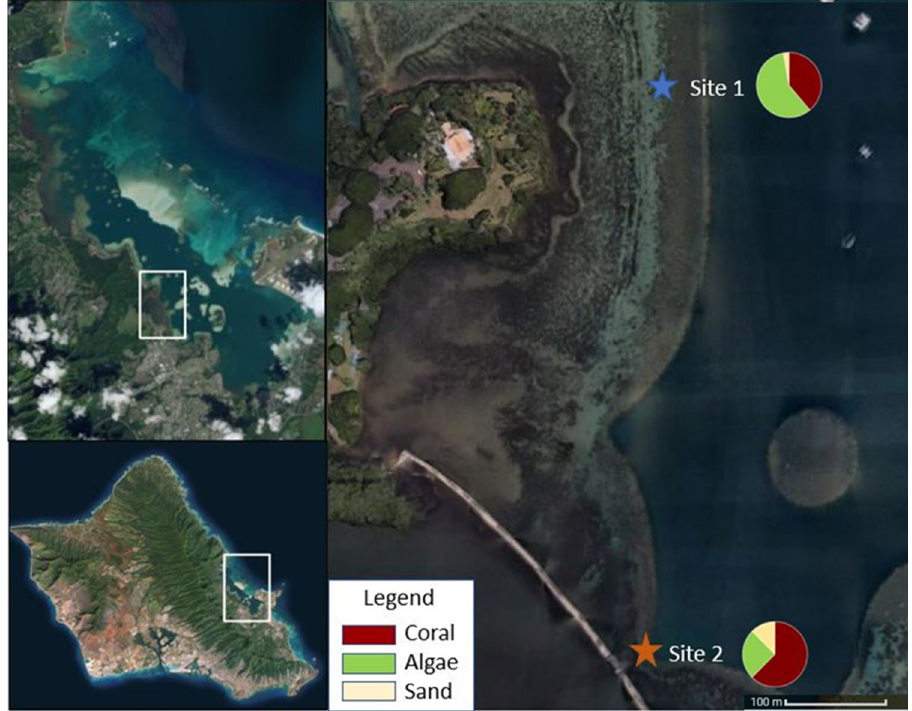
Figure 1. Map of Malauka‘a fringing reef situated in K¯ane‘ohe Bay, O‘ahu with Site 1 and Site 2 identified and benthic cover described. Picture credit: Digital Globe.